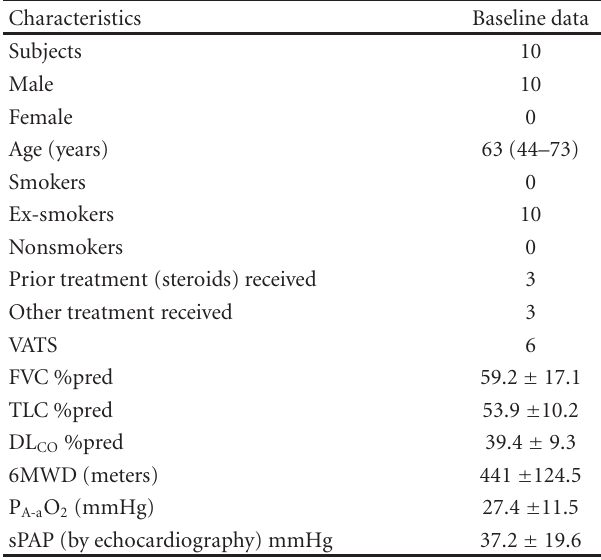
Table 1: Baseline characteristics of the study